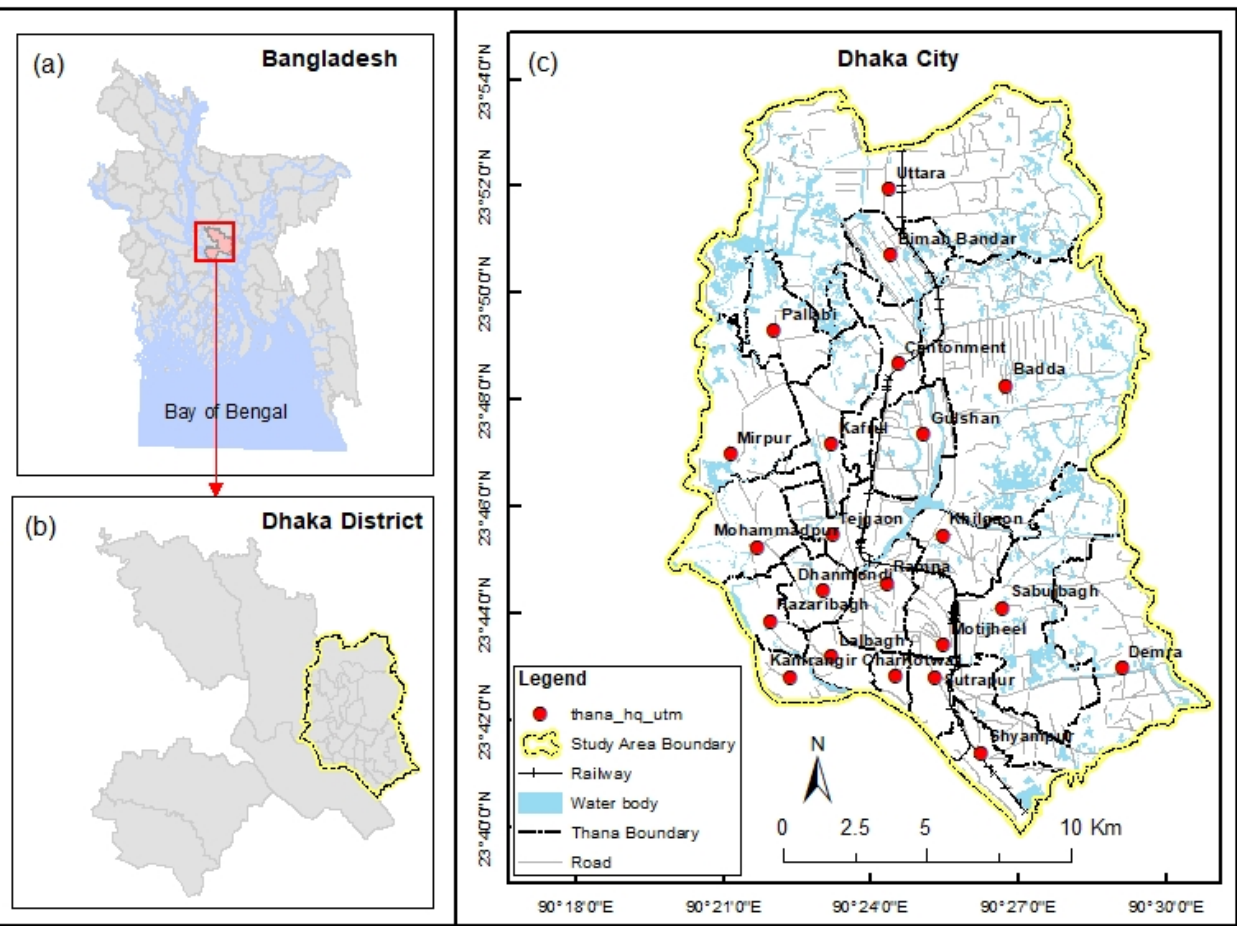
Figure 1. Location of ( a ) Dhaka district in Bangladesh; ( b ) the city of Dhaka in Dhaka district; and ( c ) base map of the city of Dhaka.